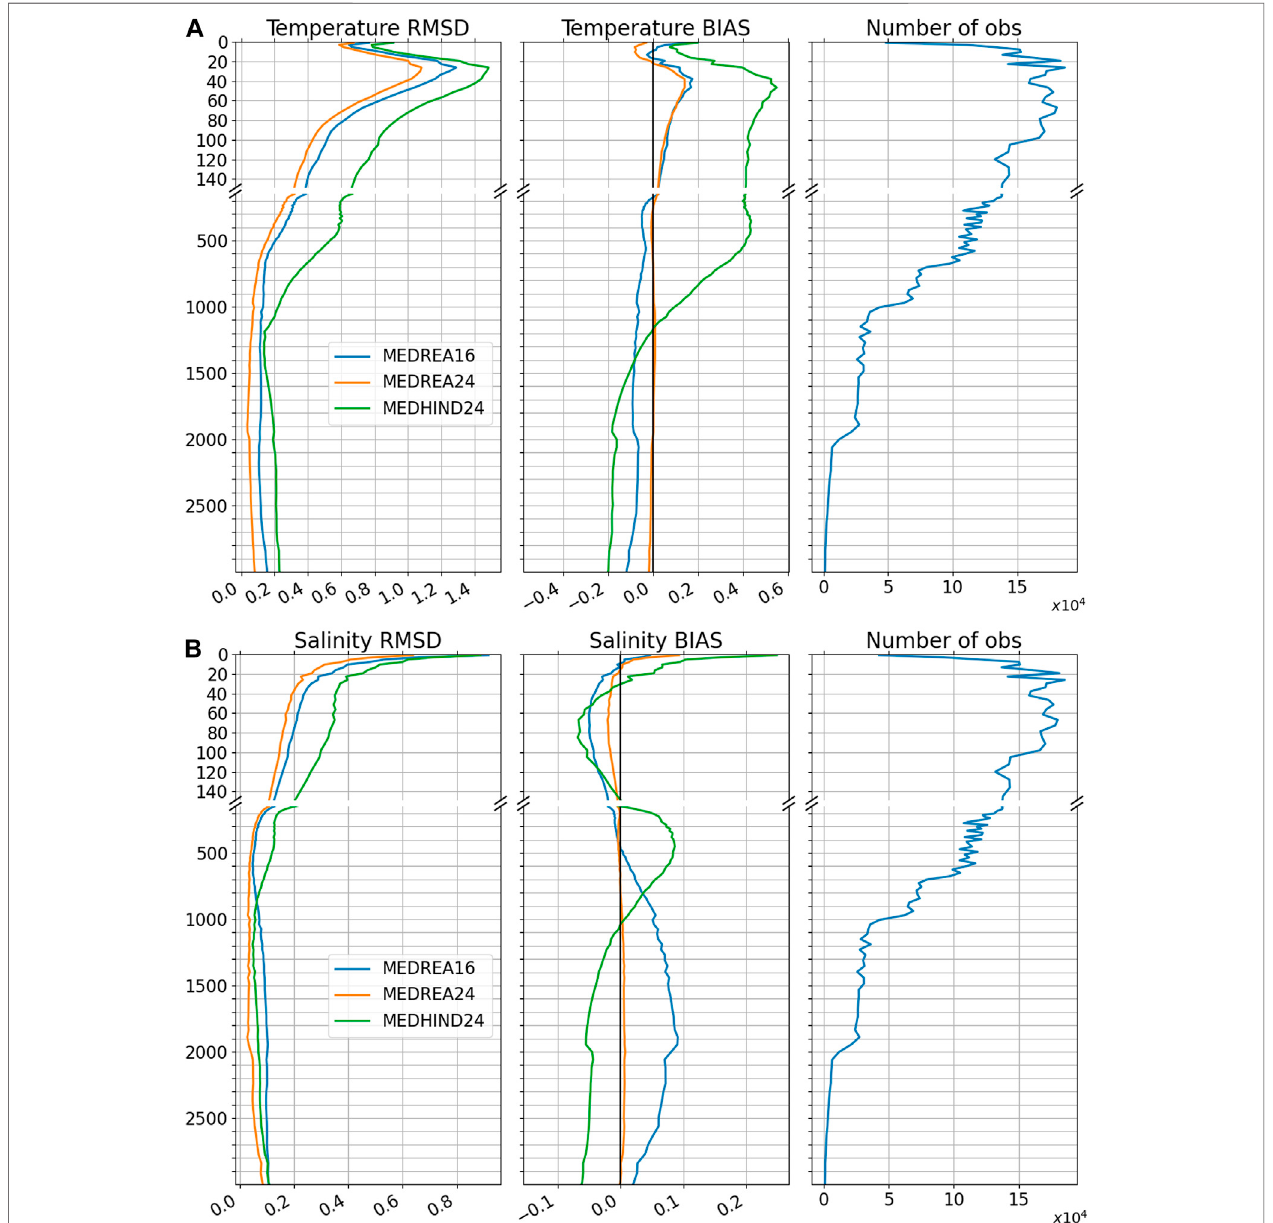
FIGURE 7 | Vertical temperature [ (A) , in ° C ] and salinity [ (B) , in PSU] diagnostics for the two reanalyses and the hindcast when compared to observed pro fi les for the whole period (1987 – 2019). The diagnostics were computed on the model layers and the right panel present the number of observations used. The vertical scale is increased on the plot for the fi rst 150 m to better see the upper layers